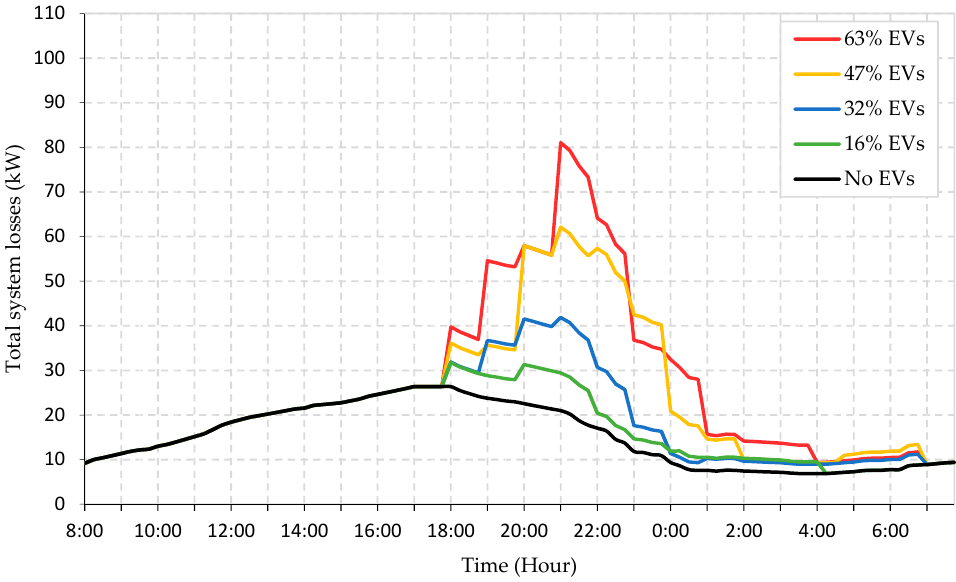
Figure 7. Impact of random uncoordinated EVs’ charging within 18:00–07:00 h on system voltage.